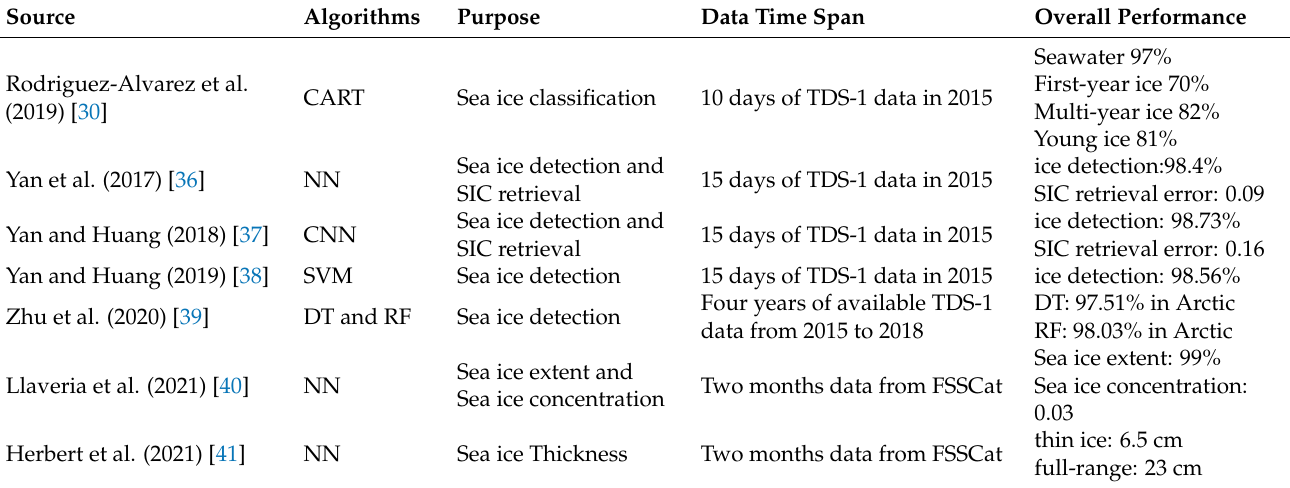
Table 1. Applications of machine learning-aided sea ice sensing using spaceborne GNSS-R